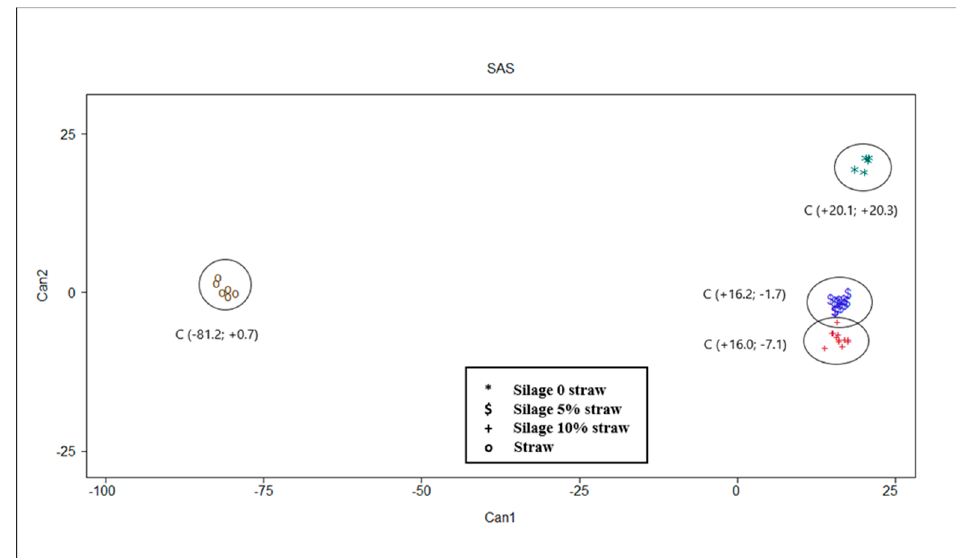
Figure 3. Plot from canonical discriminant analysis in which different feeds are distributed in function of canonical variables 1 and 2 based on chemical, silage quality and in vitro gas production parameters. Centroid coordinates in parentheses are reported.